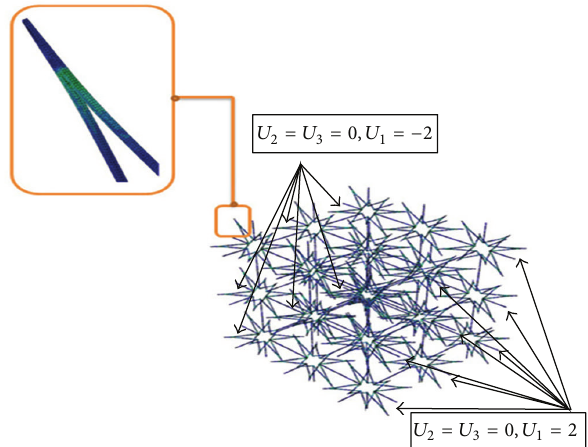
Figure 2: Von Misses stress of Model number 1 in the case of uniaxial imposed displacement along 𝑥